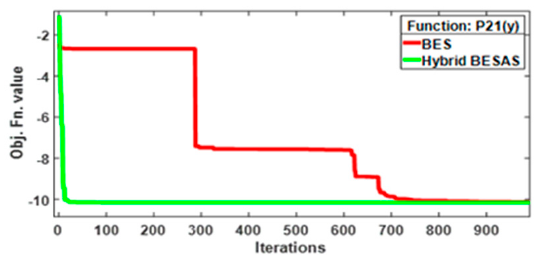
Figure 8. Convergence profile for function 𝑝 (cid:2870)(cid:2869) .